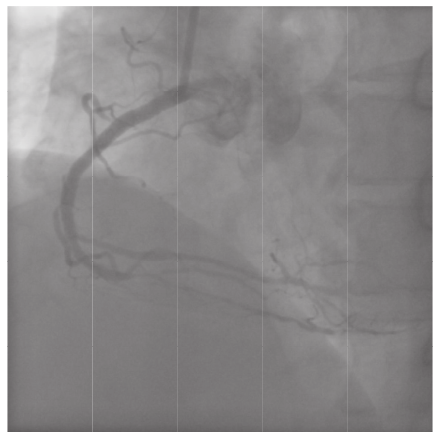
Figure 4: Final angiogram of RCA.